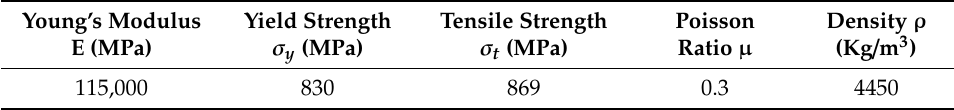
Figure 4. Spherical hull, ( a ) meshing, ( b ) boundary conditions, and loading.